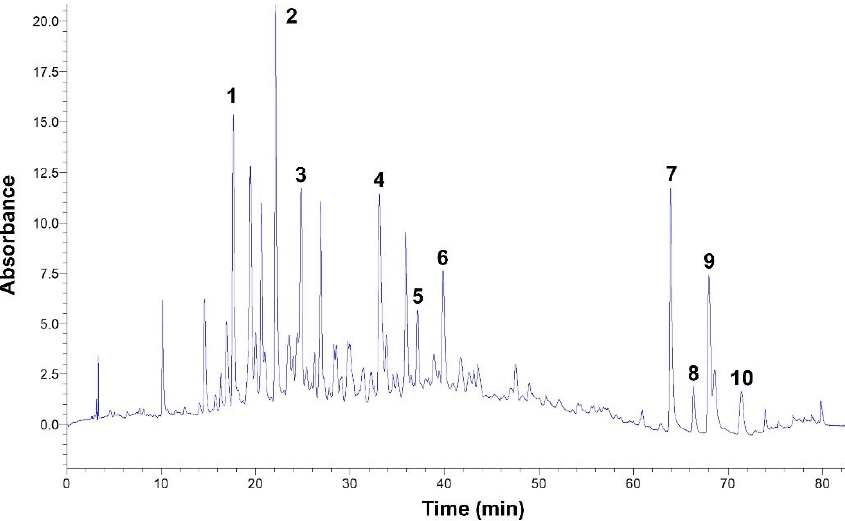
Figure 6. A typical chromatogram of a WOP aqueous extract, obtained under optimized conditions (55 °C, 60 min). The eluent was monitored at 320 nm. Peak assignment: 1, neochlorogenic acid; 2, chlorogenic acid; 3, caffeic acid; 4, ferulic acid; 5, narirutin; 6, hesperidin, 7, didymin; 8, sinensetin; 9, nobiletin; 10, dimethylnobiletin.